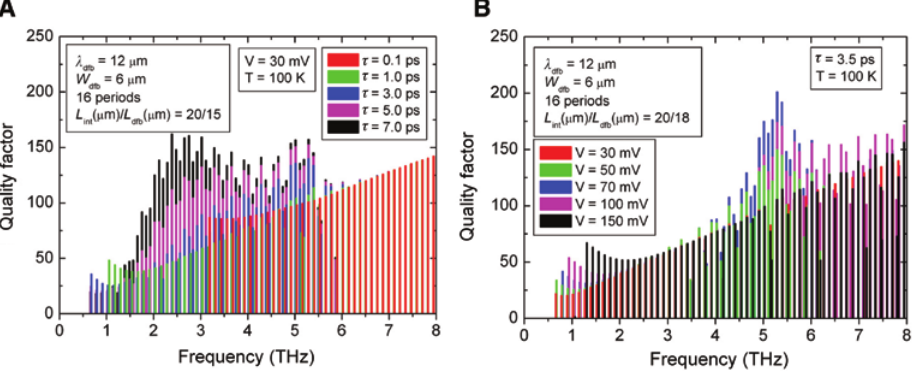
Figure 4: Simulated quality factors for in-plane waveguided modes (A) for different quality graphene samples having τ of 0.1, 1.0, 3.0, 5.0, and 7.0 ps at a fixed weak drain bias of 30 mV and (B) for different drain bias conditions at 30, 50, 70, 100, and 150 mV at a fixed τ of 3.5 ps. Numerically calculated Q factors for the case when τ is ~ 3.5 ps at relatively high drain bias conditions exhibit slightly better THz photon field